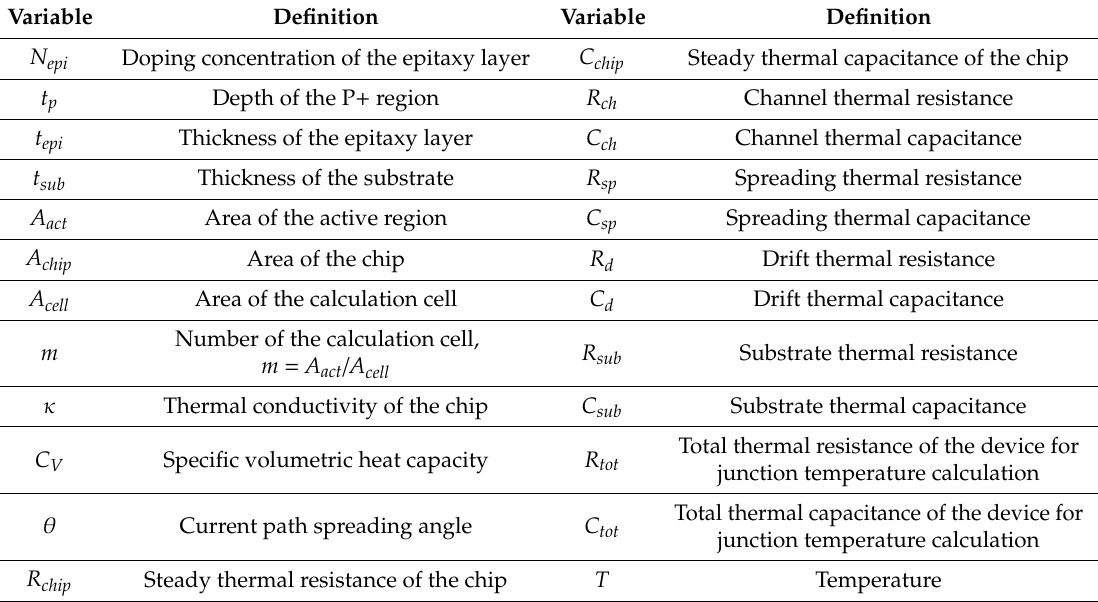
Table 1. Symbols of variables used in this paper.